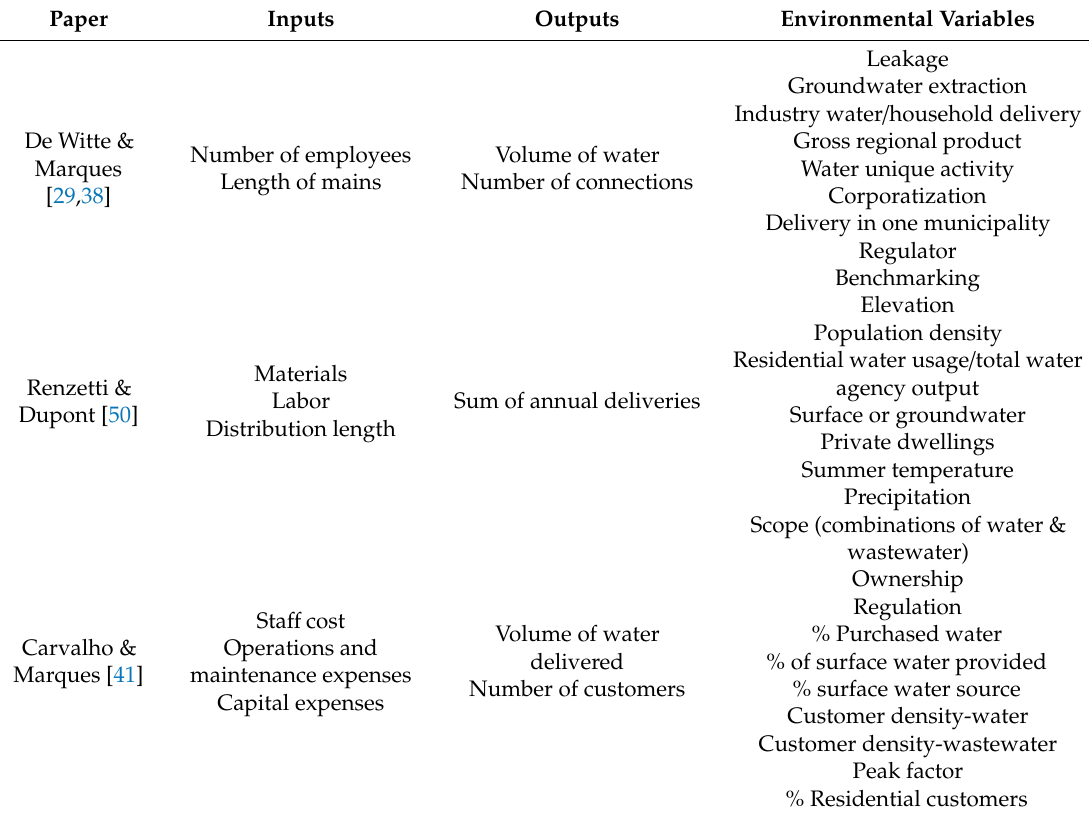
Table 7. Papers using bootstrap DEA and regression